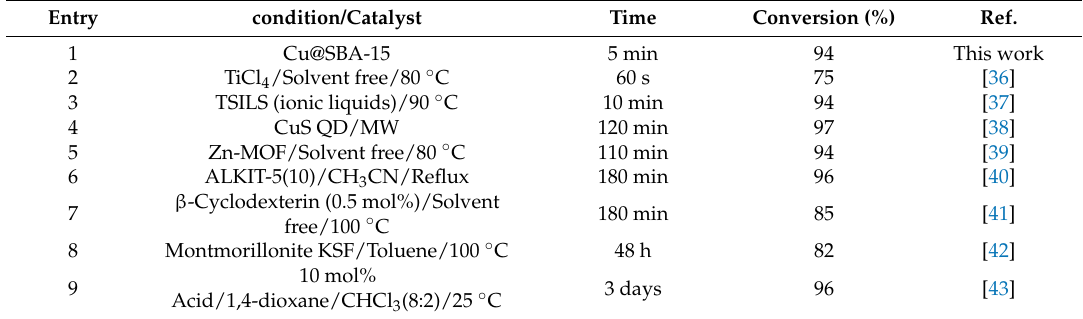
Table 3. Comparison of the efficiency of Cu@SBA-15 in the reaction of benzaldehyde, α-dicarbonyl compounds, and urea, and the previous literature.